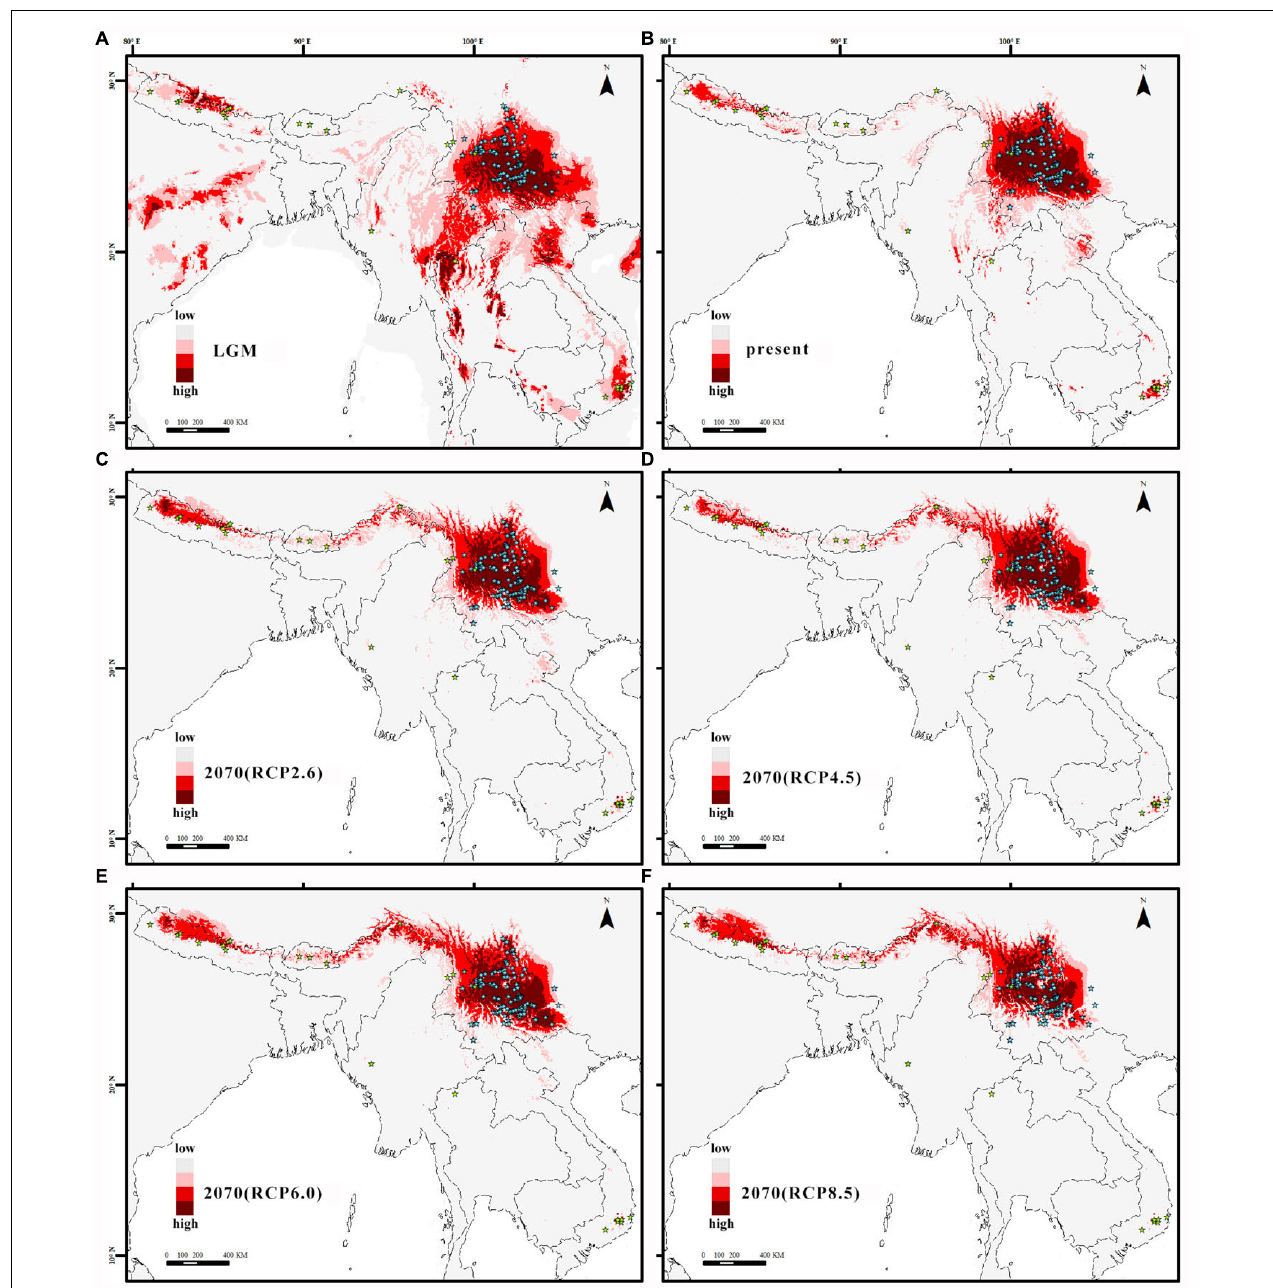
FIGURE 5 | (A) the last glacial maximum (LGM), (B) the present, (C) in 2070 under the RCP2.6 scenario, (D) in 2070 under the RCP4.5 scenario, (E) in 2070 under the RCP6.0 scenario, and (F) in 2070 under the RCP8.5 scenario. The color from pink to red represents the fitness zone, from low to high